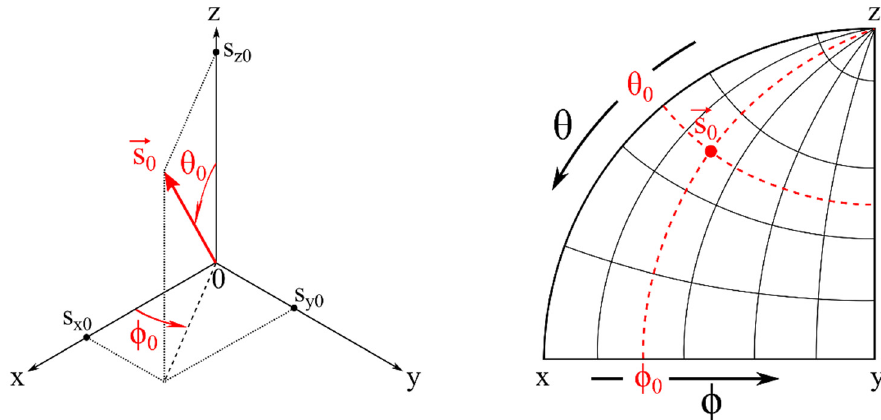
Figure 3. Wulff diagram ( right ) providing a useful planar representation of one octant ( left ) where boundaries correspond to the three principal planes of the dielectric frame. (O,x,y,z) is the dielectric frame and (𝜃 (cid:3042) , 𝜙 (cid:2868) ) are spherical angles of unit vector 𝑠⃗ (cid:2868) standing for any direction of propagation.